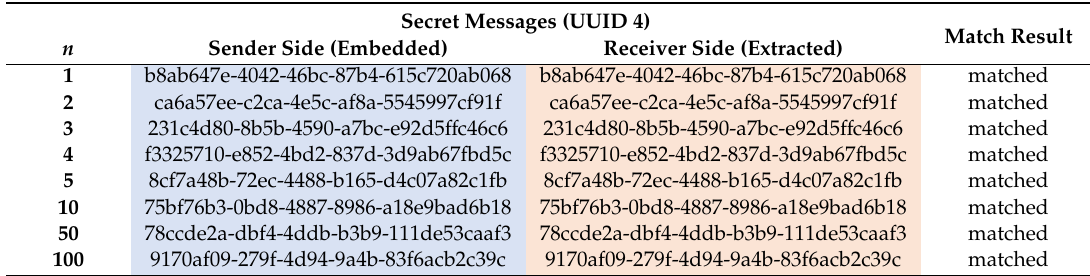
Table 1. A part of the result of experiment 1. Part